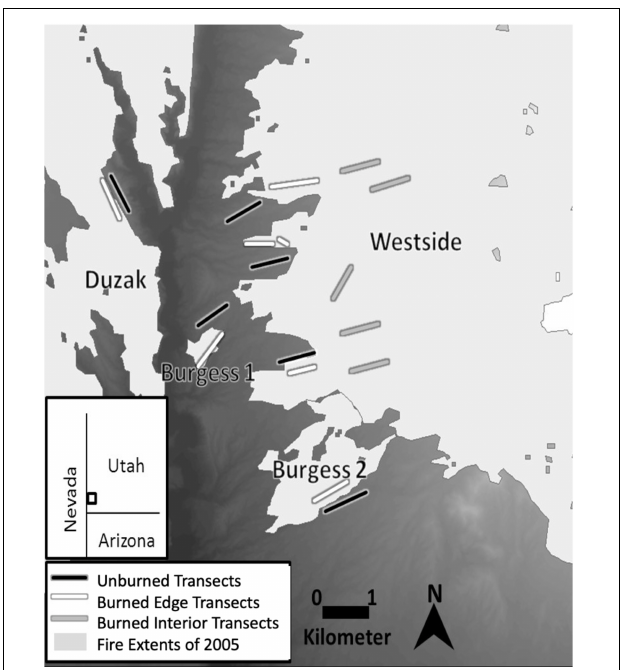
FIGURE 1 | Map of Beaver Dam Wash (N37.14, W114.03) study site. Transect lines in four independent burns that occurred in the summer of 2005 with 1 km long transects along unburned (black), burned edge (white) and burned interior (gray) locations in the landscape. Study area is located in the southwest corner of